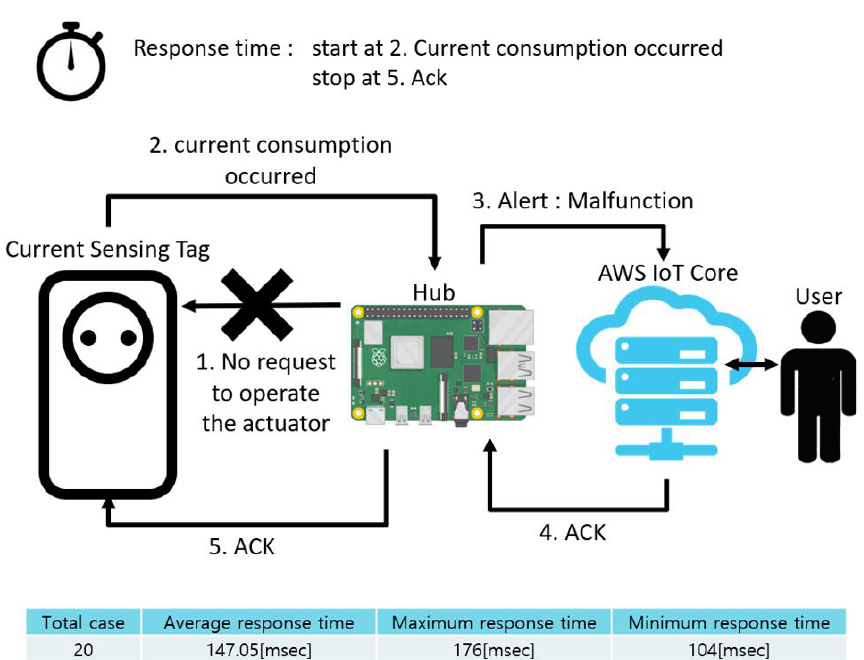
Figure 23. Response time in exceptional case: actuator off.